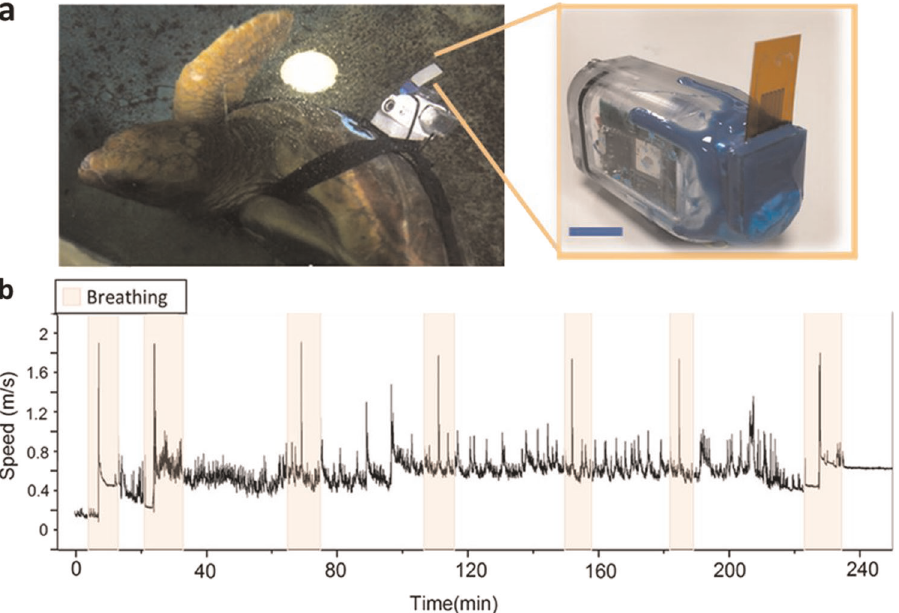
Fig. 11 a LIG bending sensor integrated with commercial tag (scale bar: 1 cm) and attached to the sea turtle. b The recorded speed of sea turtle as a function of time for a duration of 4